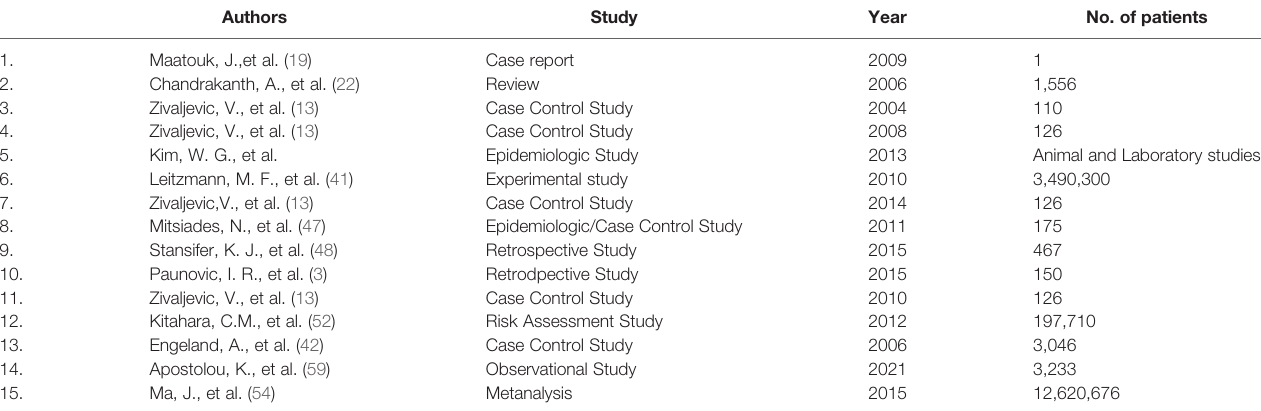
TABLE 3 | Summary of studies